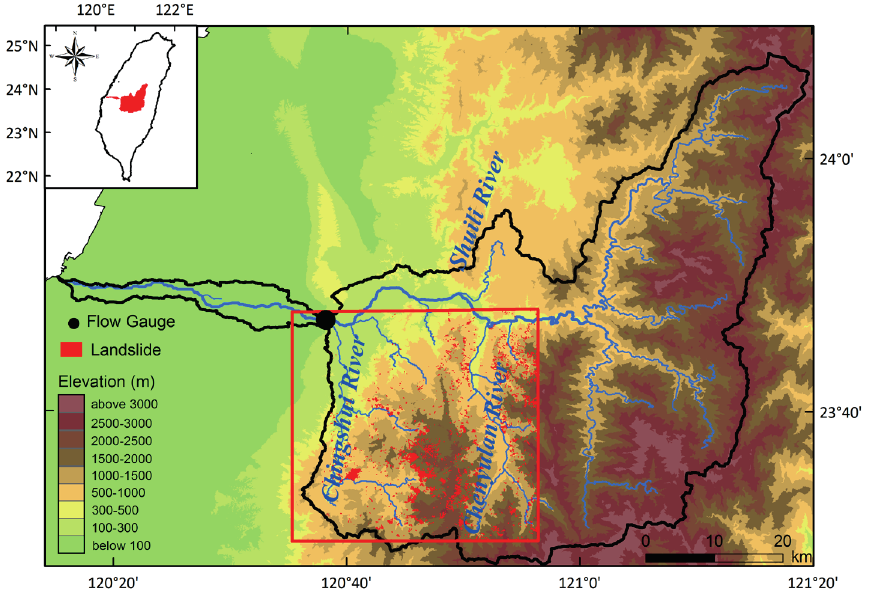
Fig. 1 The Choshui River drainage basin, showing also the Chenyulan and Chingshi tributaries. The small red dots indicate locations of Chichi-generated landslides, primarily in the Chenyulan and Chingshui